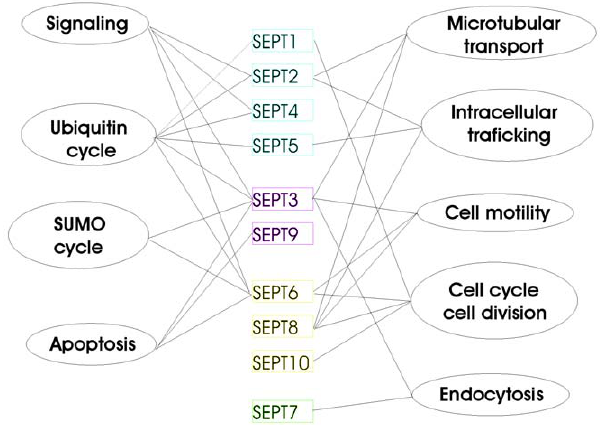
Figure 5. Non-septin interactors of the septins 1-10 grouped by functional categories. The group wise clustering of functional contexts is evident. The most predominant functions are emphasized only in order not to pollute the figure with excessive information. Septins are shown clustered into the four groups: SEPT2, SEPT3, SEPT6 and SEPT7 from top to bottom in different